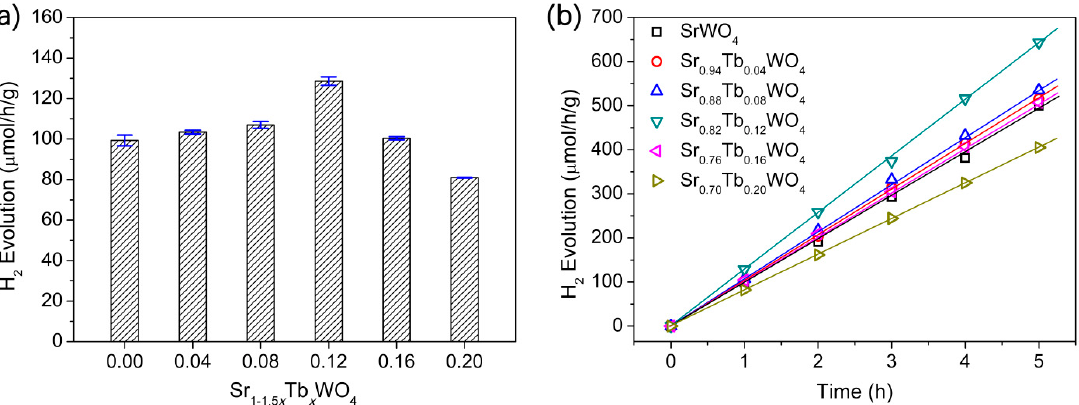
Figure 7. ( a ) The H 2 evolution rates of Sr 1 − 1.5 x Tb x WO 4 samples against increasing x . ( b ) The H 2 evolution of Sr 1 − 1.5 x Tb x WO 4 samples against time. Photocatalytic conditions: 50 mg photocatalyst, 50 mL 5% aqueous triethanolamine (TEOA) solution, 500 W Hg lamp.